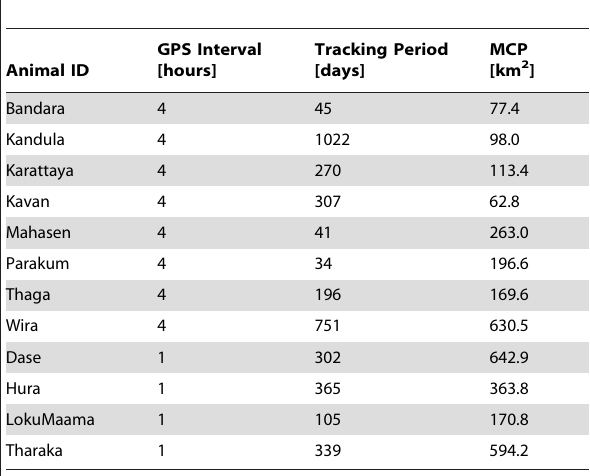
Table 2. Details of collar programming and home ranges (MCP) for resident